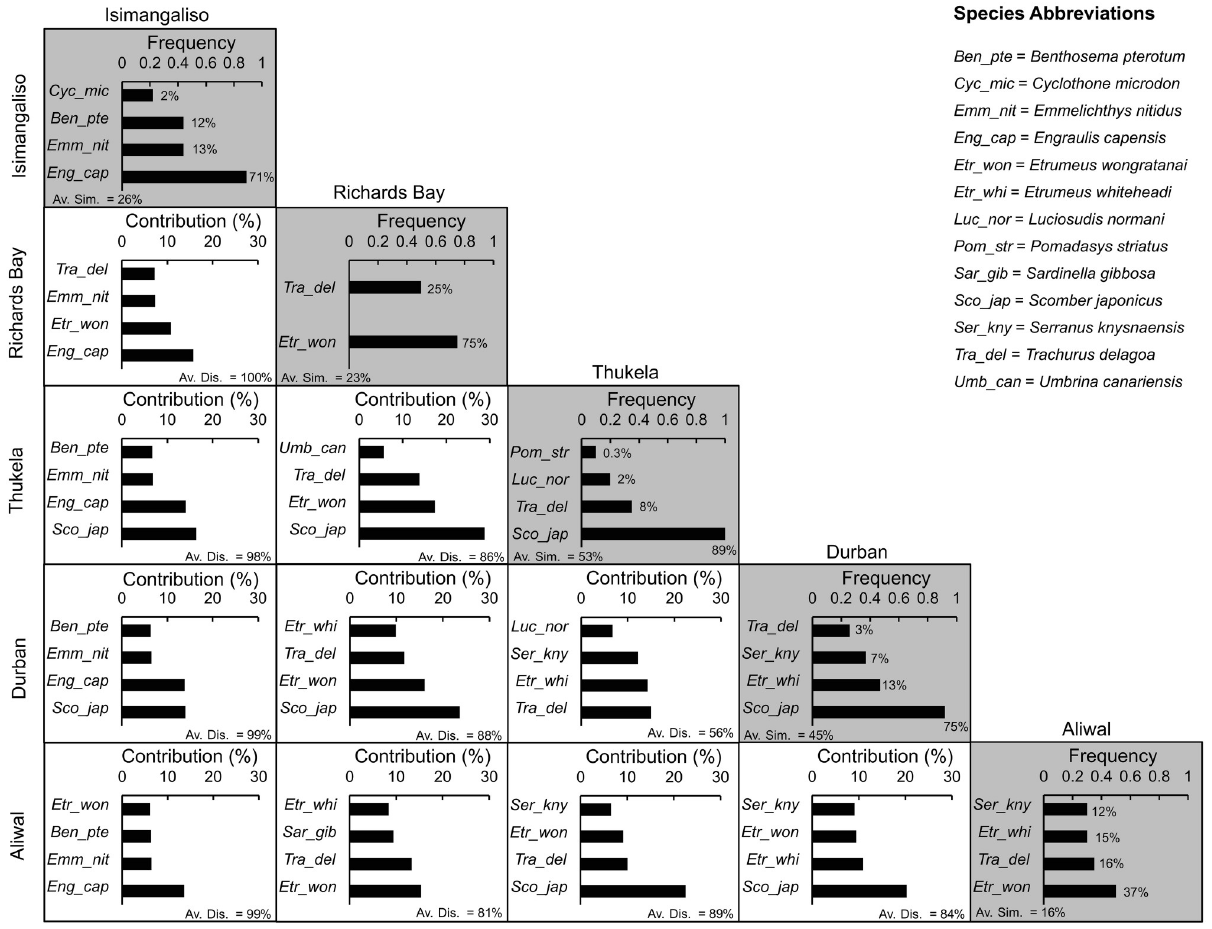
Fig 6. Similarity percentage breakdown (SIMPER) analysis of ichthyoplankton presence-absence data according to transect (north to south). The grey blocks indicate the top-four (most characteristic) species in each transect based on their frequency of presence relative to the total number of samples in that transect, along with the species’ contributions (%) towards the average similarity (Av. Sim.) of that transect. The white blocks represent the top-five species which had the largest contribution (%) to the average dissimilarity (Av. Dis.) between